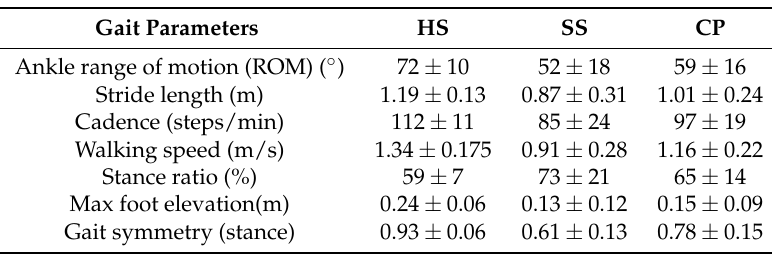
Gait posture assessment results of healthy subjects (HS), stroke survivors (SS), and convalescence patients (CP). Gait Parameters